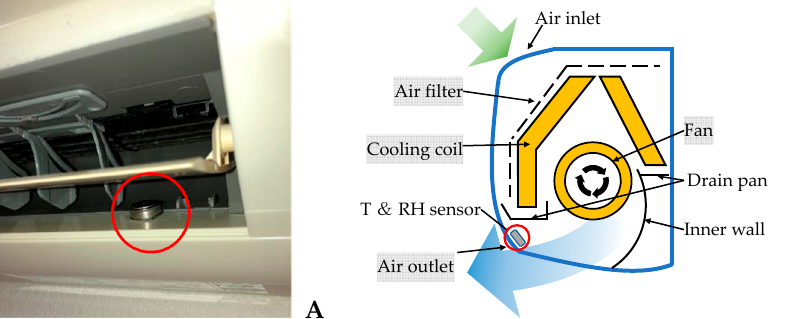
Figure 1. Location of sensors for measuring T and RH at air the conditioner air outlet (1A), configuration of the ductless mini- split-type AC unit (1B)